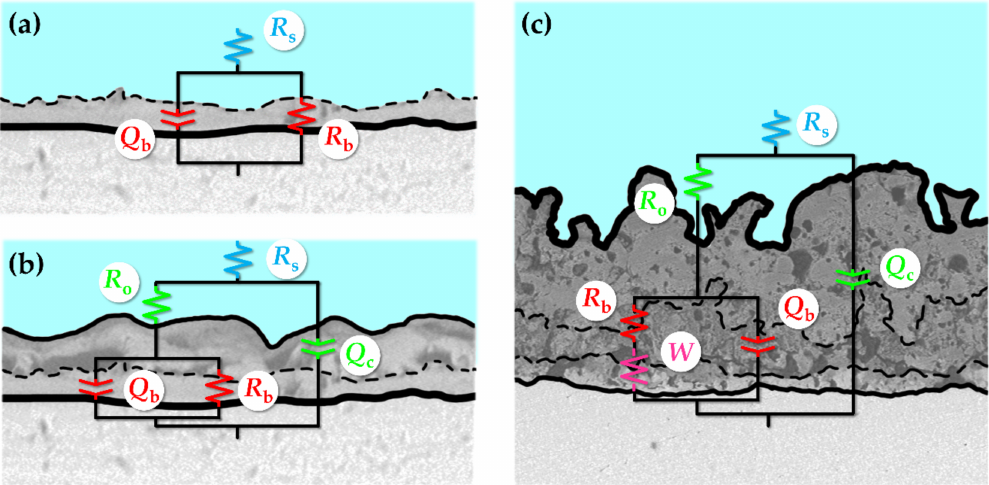
Figure 7. Equivalent electrical circuits used for fitting of the impedance spectra of the untreated Ta sample ( a ), the PEO samples that showed 2 time constants ( b ), and those that exhibited 2 time constants with a linear constant-phase region ( c